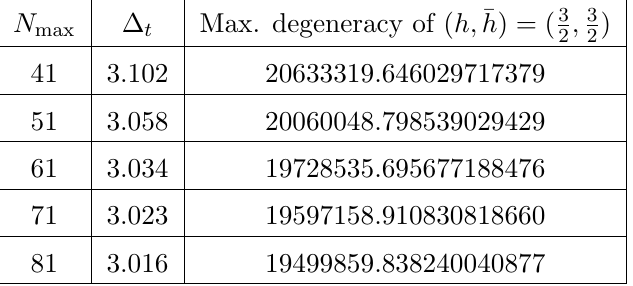
Table 14. The degeneracy upper bound of weight ( h; (cid:22) h ) = ( 3